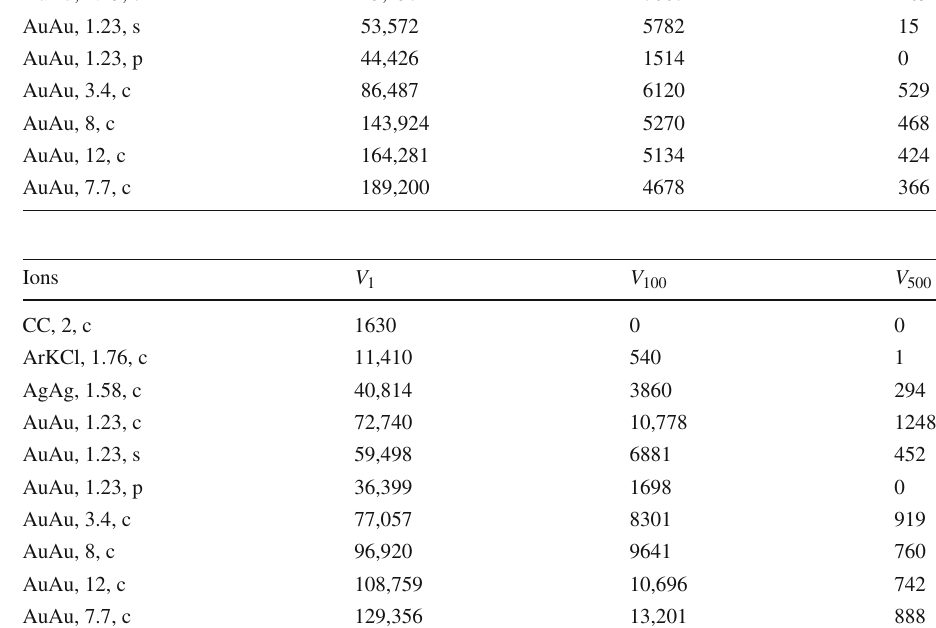
Table 11 Results for X < 0 . 1 and Y < 0 . 3